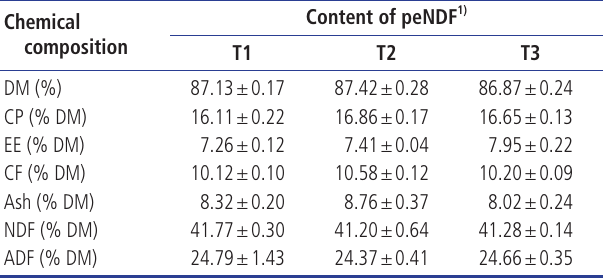
Table 2. Chemical composition of the experimental TMR feed with different